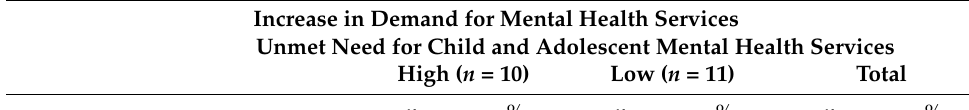
Table 3. Increase and decrease in demand for mental health service by rates of coronavirus positivity and unmet need for child and adolescent mental health